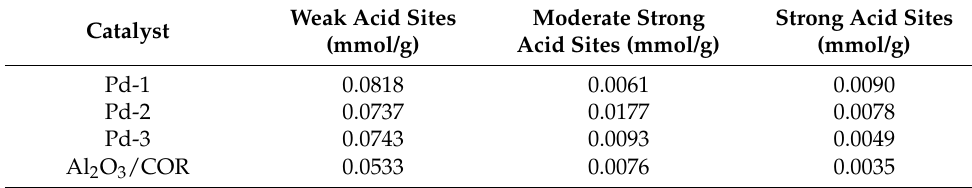
Figure 6. NH 3 -TPD of Pd-1, Pd-2, Pd-3 and Al 2 O 3 /COR. Table 4. Surface acidic sites of Pd-1, Pd-2, Pd-3 and Al 2 O 3 /COR.